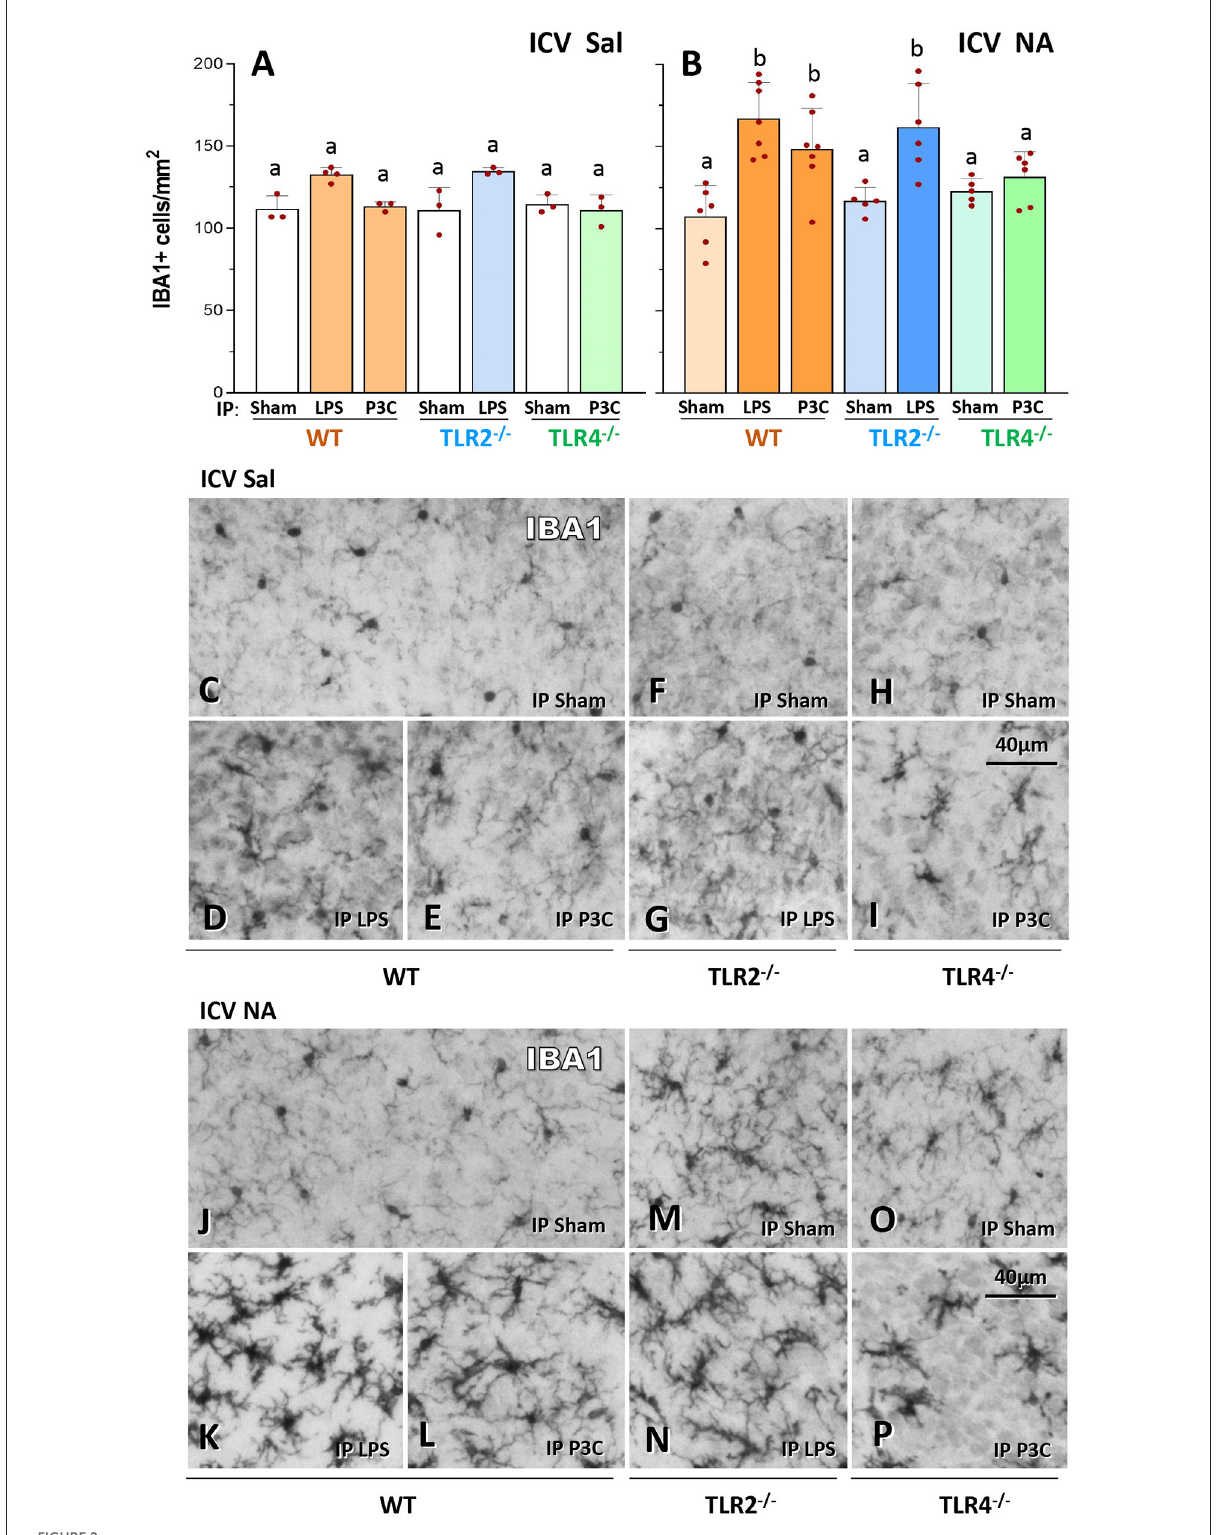
FIGURE2 IBA1-positive cell counts in the hypothalamus of WT, TLR2 − / − and TLR4 − / − mice after a double inflammatory stimulus. IBA1-positive cells (microglia) were counted in the medio-dorsal periventricular region of the third ventricle (A,B) . Microglial density was higher in WT and TLR2 − /